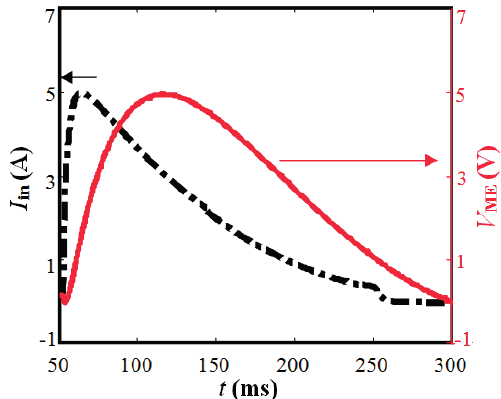
Figure 10. Typical acquired waveforms for conducting one test.